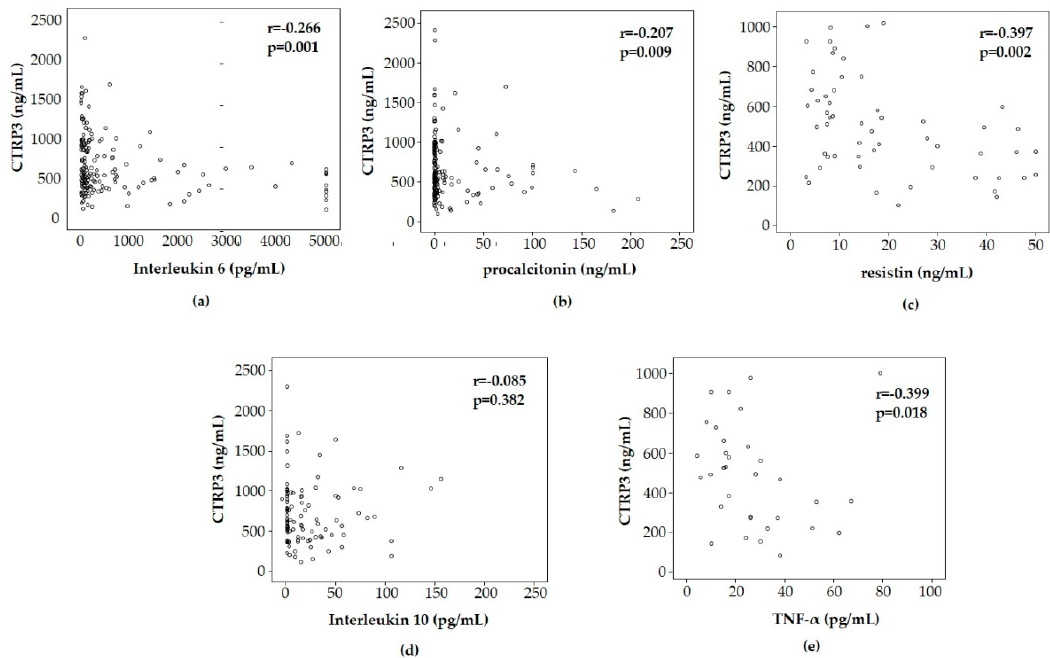
Figure 2. CTRP3 levels correlate inversely with inflammatory response (Spearman rank correlation test). CTRP3 plasma levels, at time of admission to the ICU, are correlated inversely with inflammatory biomarkers such as serum interleukin 6 ( a ), procalcitonin ( b ), and TNF- α ( e ), but not IL-10 ( d ). CTRP3 correlated inversely with serum resistin concentrations in ICU patients ( c ). TNF: tumor necrosis factor; IL-10: interleukin 10.